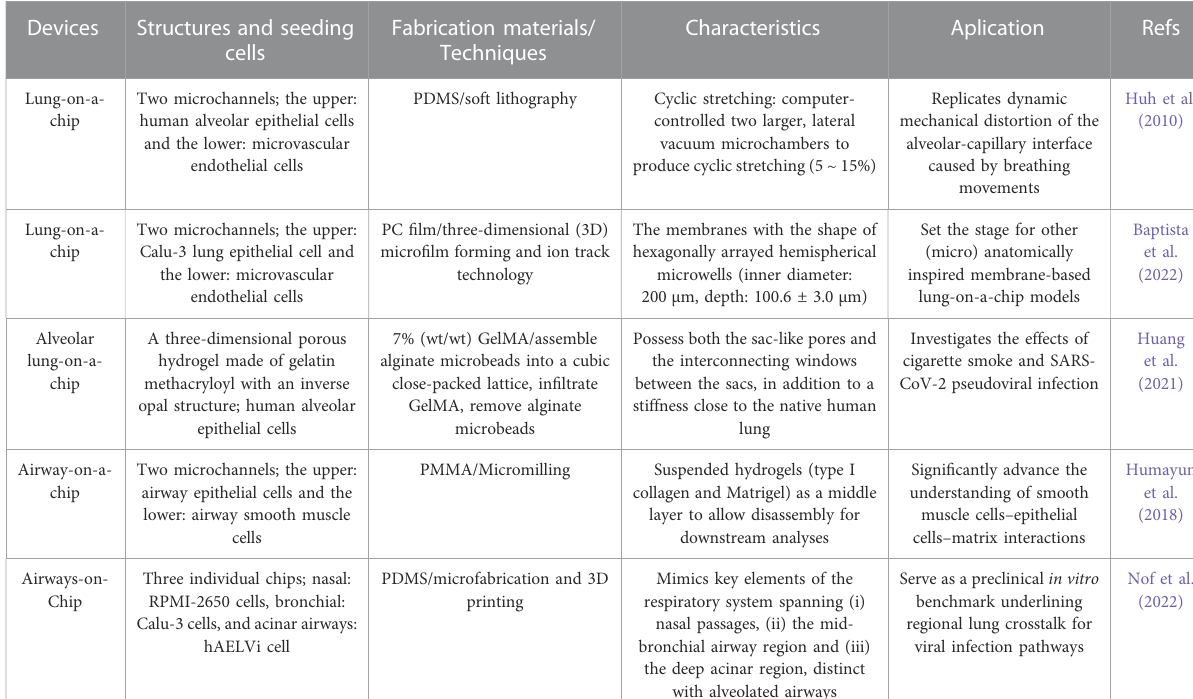
TABLE 3 List for characteristics and application of current lung-on-a-chip